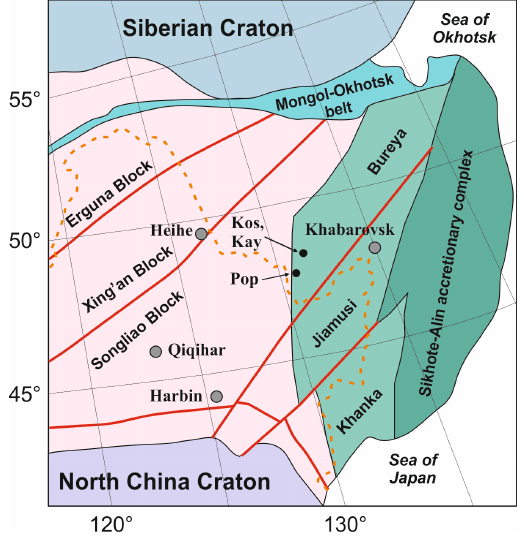
Figure 1. Tectonic setting of the Poperechnoye (Pop), Kostenga (Kos) and Kaylan (Kay) iron oxide deposits in the Russian Far East modified after [66]. Yellow dashed line depicts state border between China and Russian